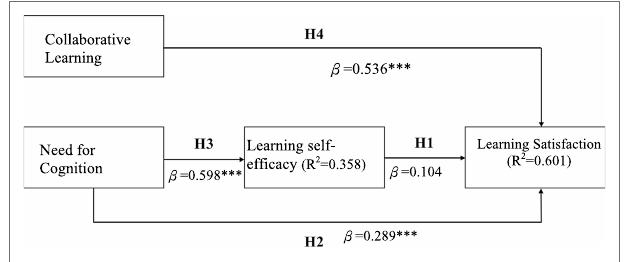
FIGURE 3 | Path analysis results. *** p < 0.05